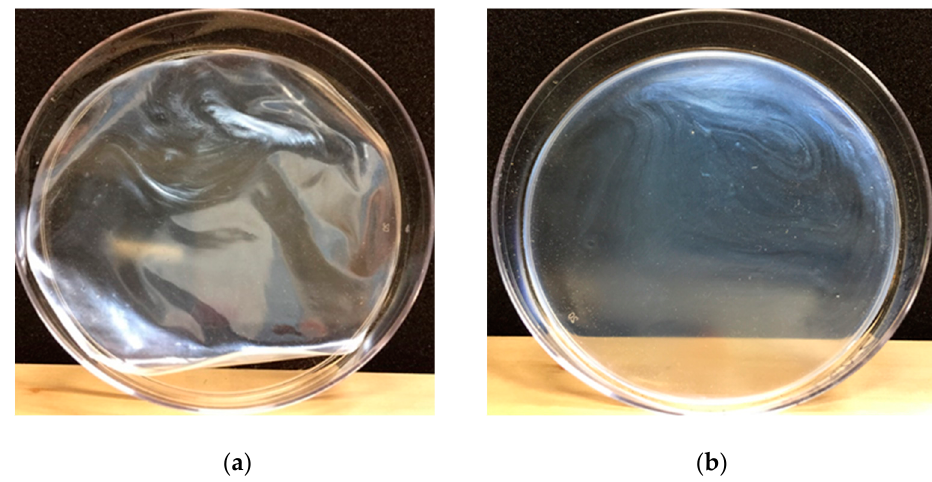
Figure 6. Solidified films from casting solutions ( a ) CNC_O and ( b ) CNC_M.